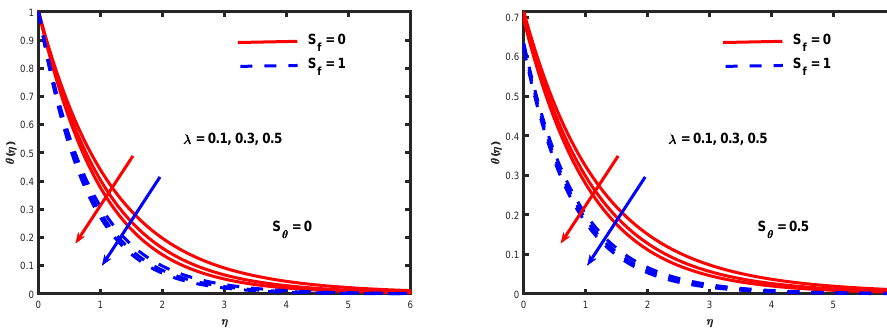
Figure 12. Influence of buoyancy parameter and hydrodynamic slip on θ .